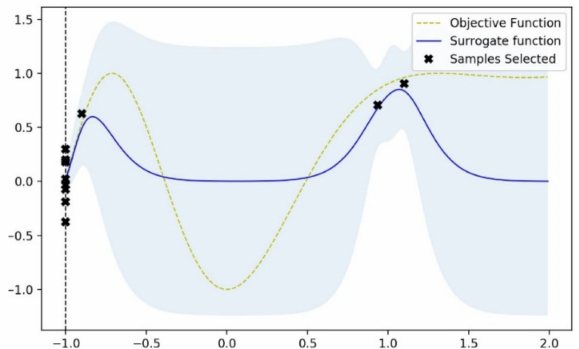
Figure A3. Plot representing an objective function, Gaussian based surrogate function and expected improvement-based samples selected for optimization of surrogate function to match the true objective function.